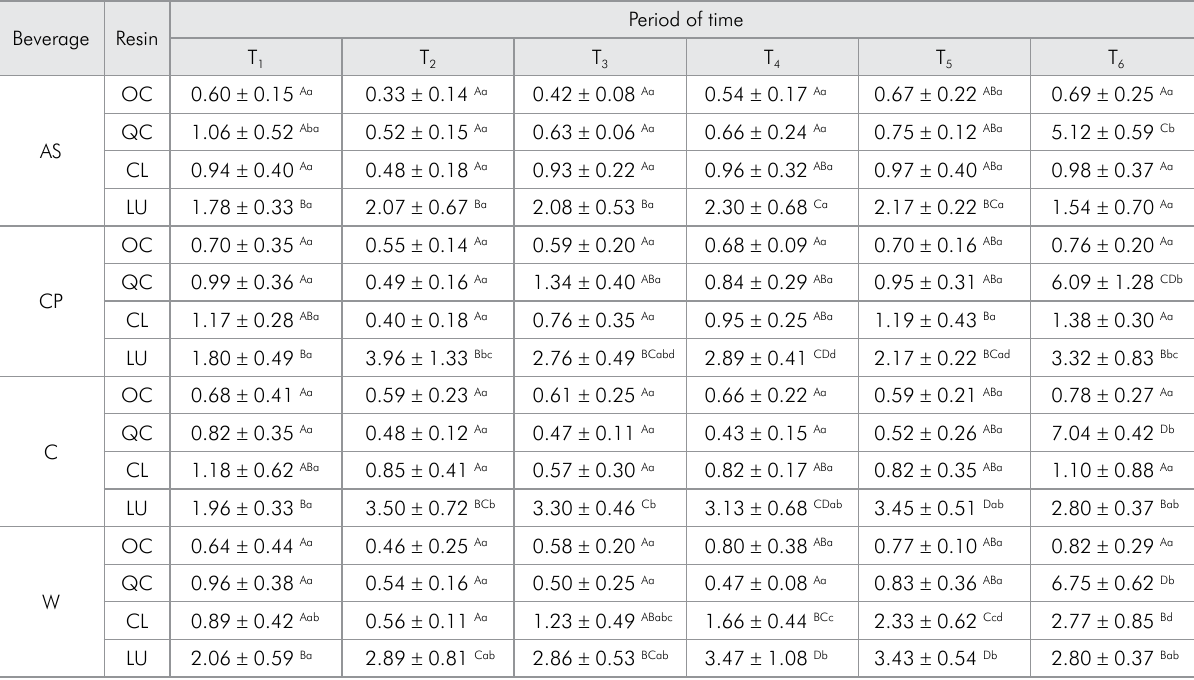
Table 6 - Color changes (mean values ± standard deviation) of each acrylic resin in each beverage. Beverage Resin